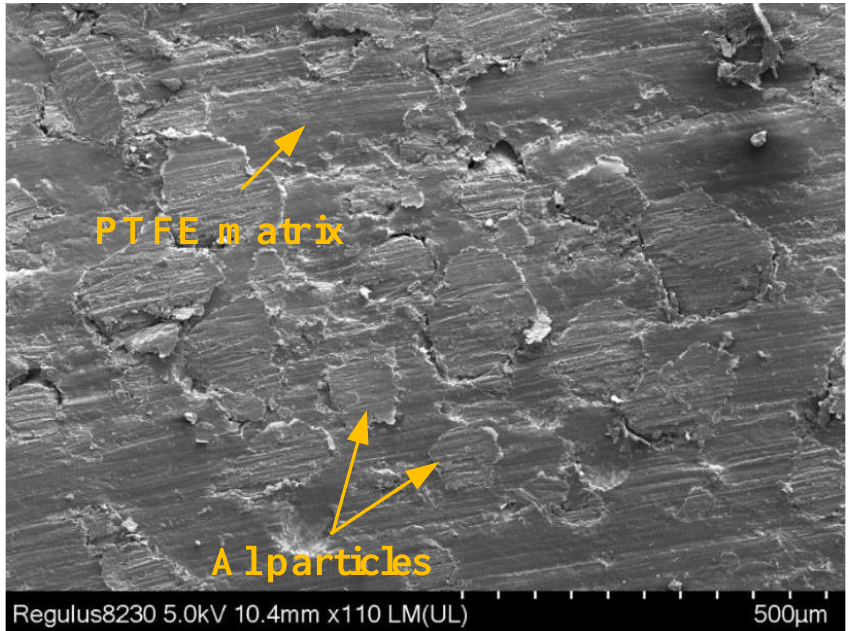
Figure 17. SEM of Al/PTFE reactive composites.